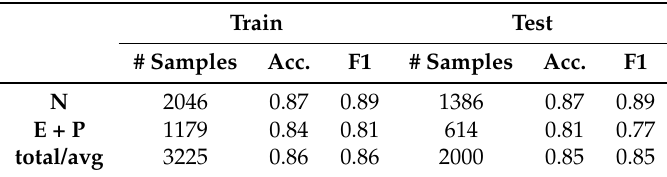
Table 7. Evaluation results for the binary classification